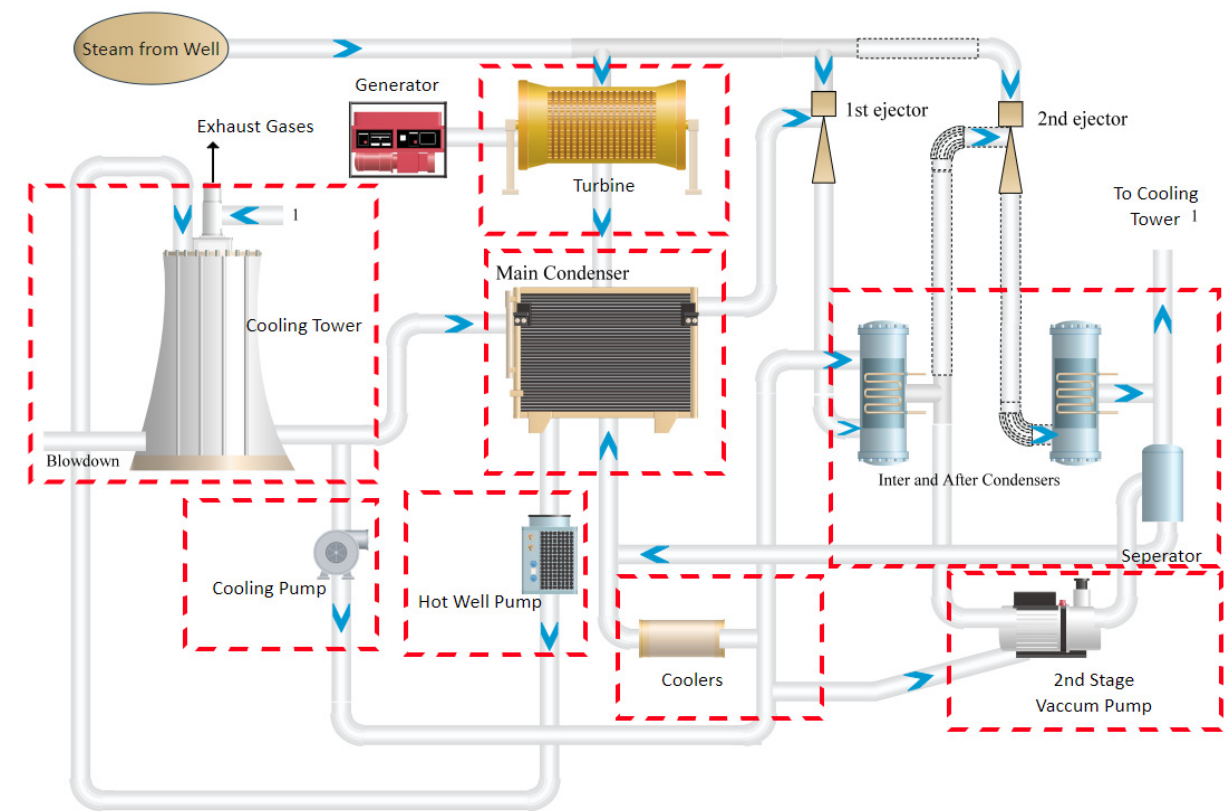
Figure 2. Flowchart of cost model generation.